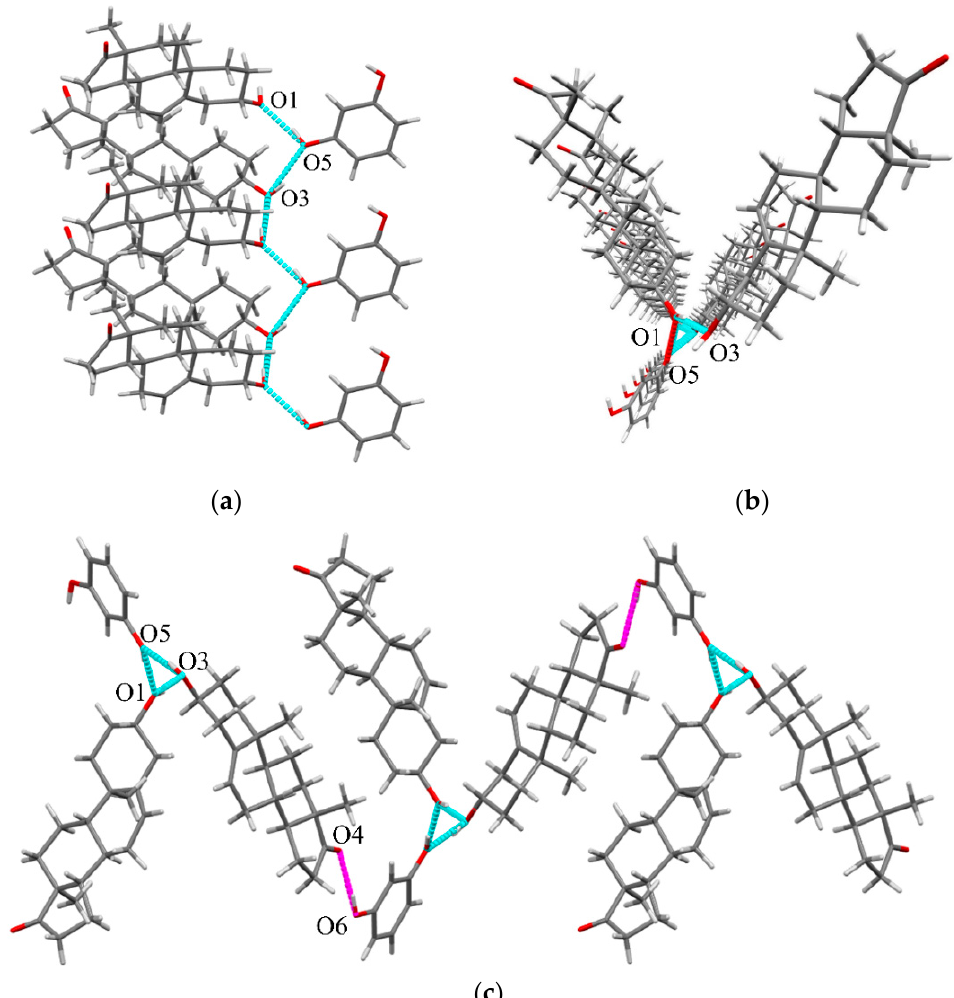
Figure 5. ( a ) 1D hydrogen-bonding interaction, ( b ) supramolecular three-fold helix, and ( c ) 3D architecture of DHEA-RES.